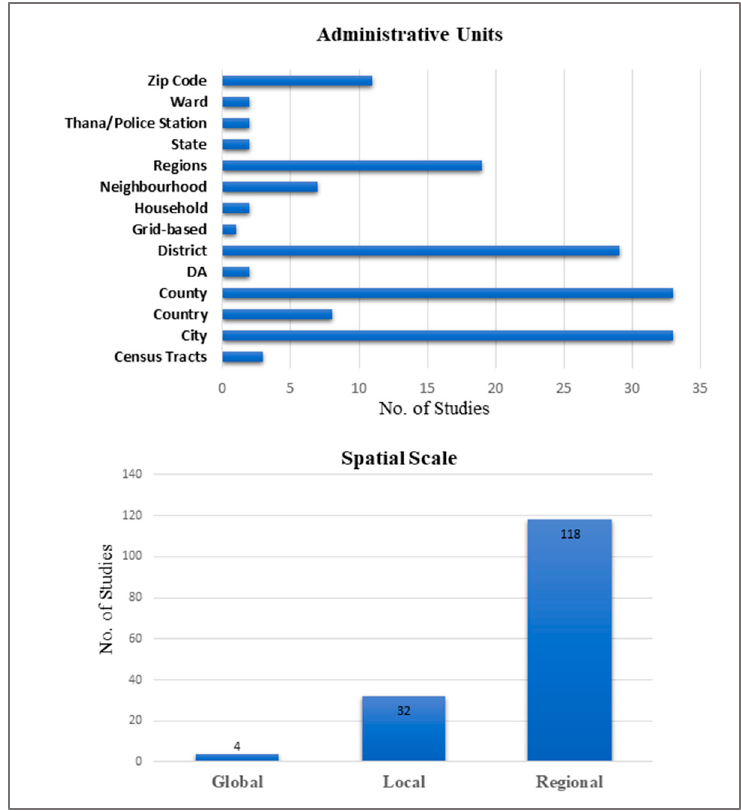
Figure 2. Geographical units, spatial scale and length of studies ( n = 154).